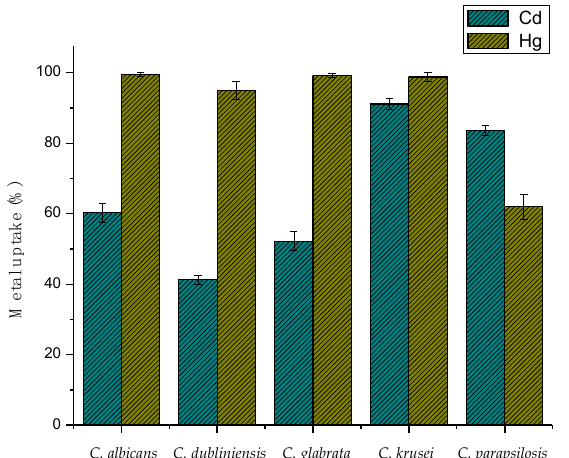
Figure 3. Cadmium and mercury uptake percentages of the five used Candida species when exposed to 0.5 mM Cd–Hg mixture during 48 h.